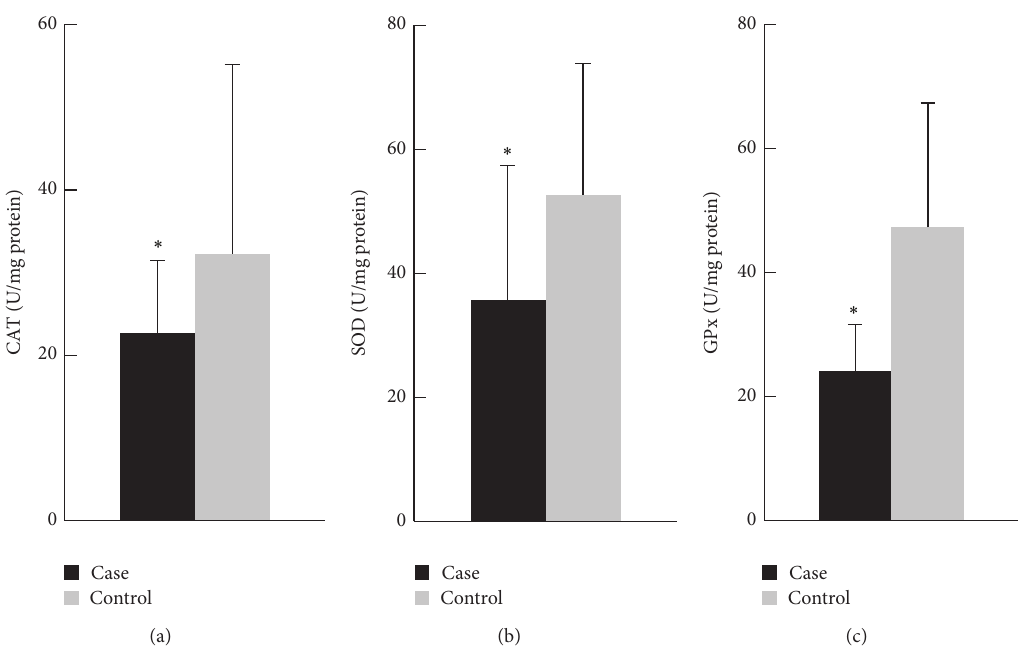
Figure 2: The levels of antioxidant enzymes. ∗ Values were significantly different between case and control groups; 𝑃 < 0.05 . CAT: catalase activity; GPx: glutathione peroxidase; SOD: superoxide